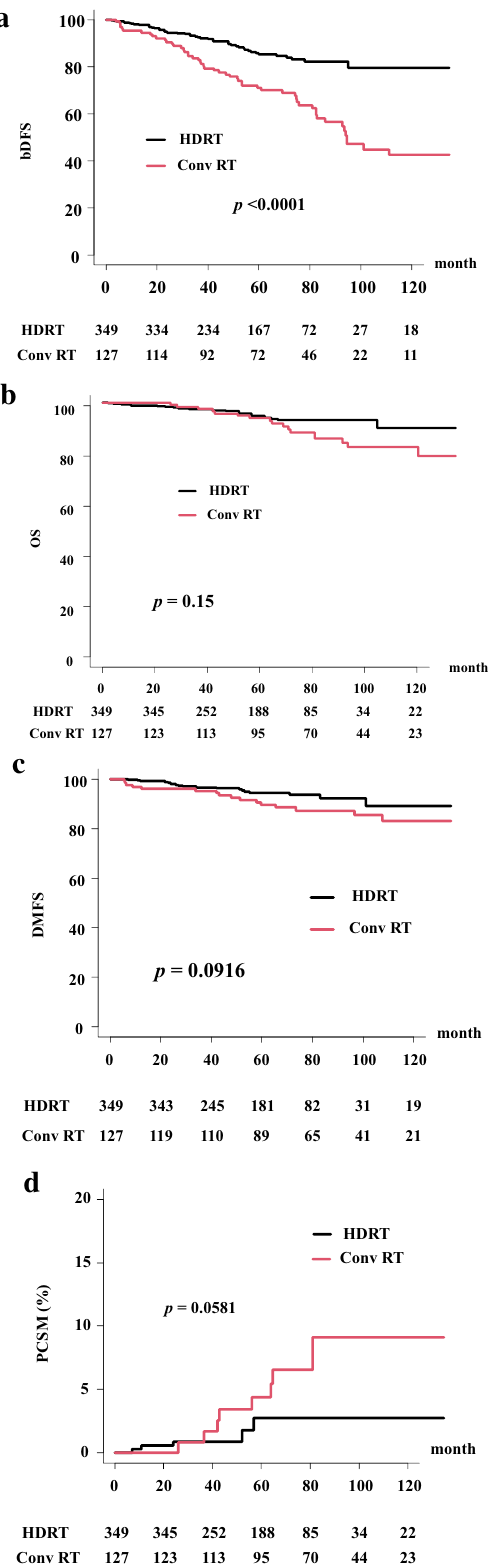
Figure 2. Comparison between Conv RT and HDRT groups. ( a ) Biochemical disease-free survival (bDFS) between Conv RT and HDRT. ( b ) Overall survival rate (OS) between Conv RT and HDRT. ( c ) Distant metastasis free survival rate (DMFS) between Conv RT and HDRT. ( d ) Prostate cancer specific mortality (PCSM) between Conv RT and